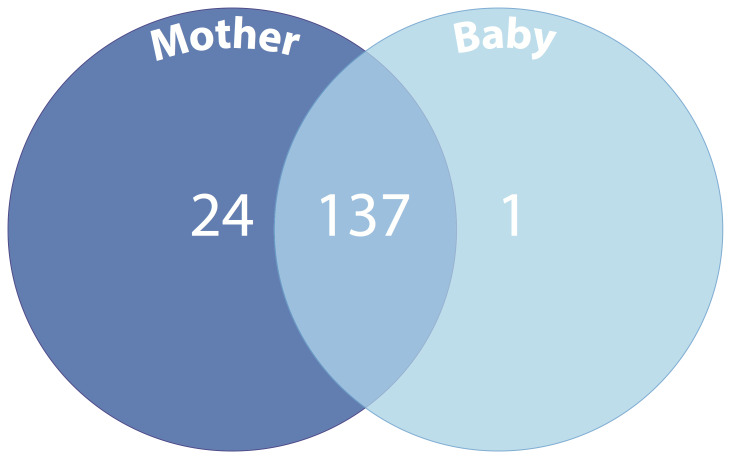
Venn diagram demonstrating DNA samples received: 24 mother only samples, 1 baby only sample and 137 mother and baby paired samples.